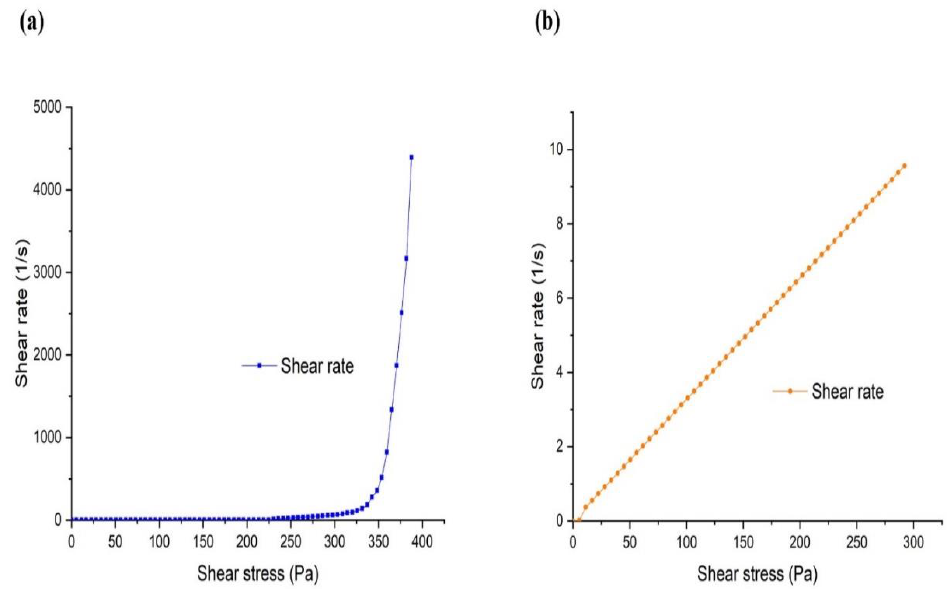
Figure 3. Rheological behavior of ( a ) the moisturizing cream (F4) and ( b ) the lotion (F5).